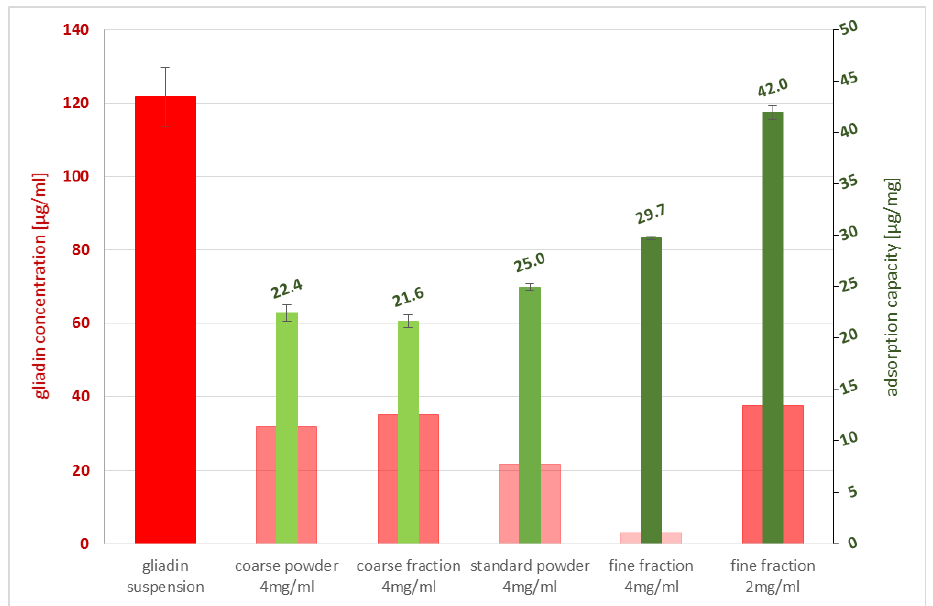
Figure 2. Gliadin concentrations in supernatants after incubation with different purified clinoptilolite-tuff fractions and adsorption capacity of different PCT fractions and concentrations concerning gliadin binding. PCT was used in different grindings to define the most sufficient size for gliadin binding by ELISA. The diagram illustrates the amount of gliadin found in the supernatants after incubation (wide red columns). Every single corresponding narrow green bar gives the specific binding potential of gliadin to purified clinoptilolite-tuff in [µg/mg].